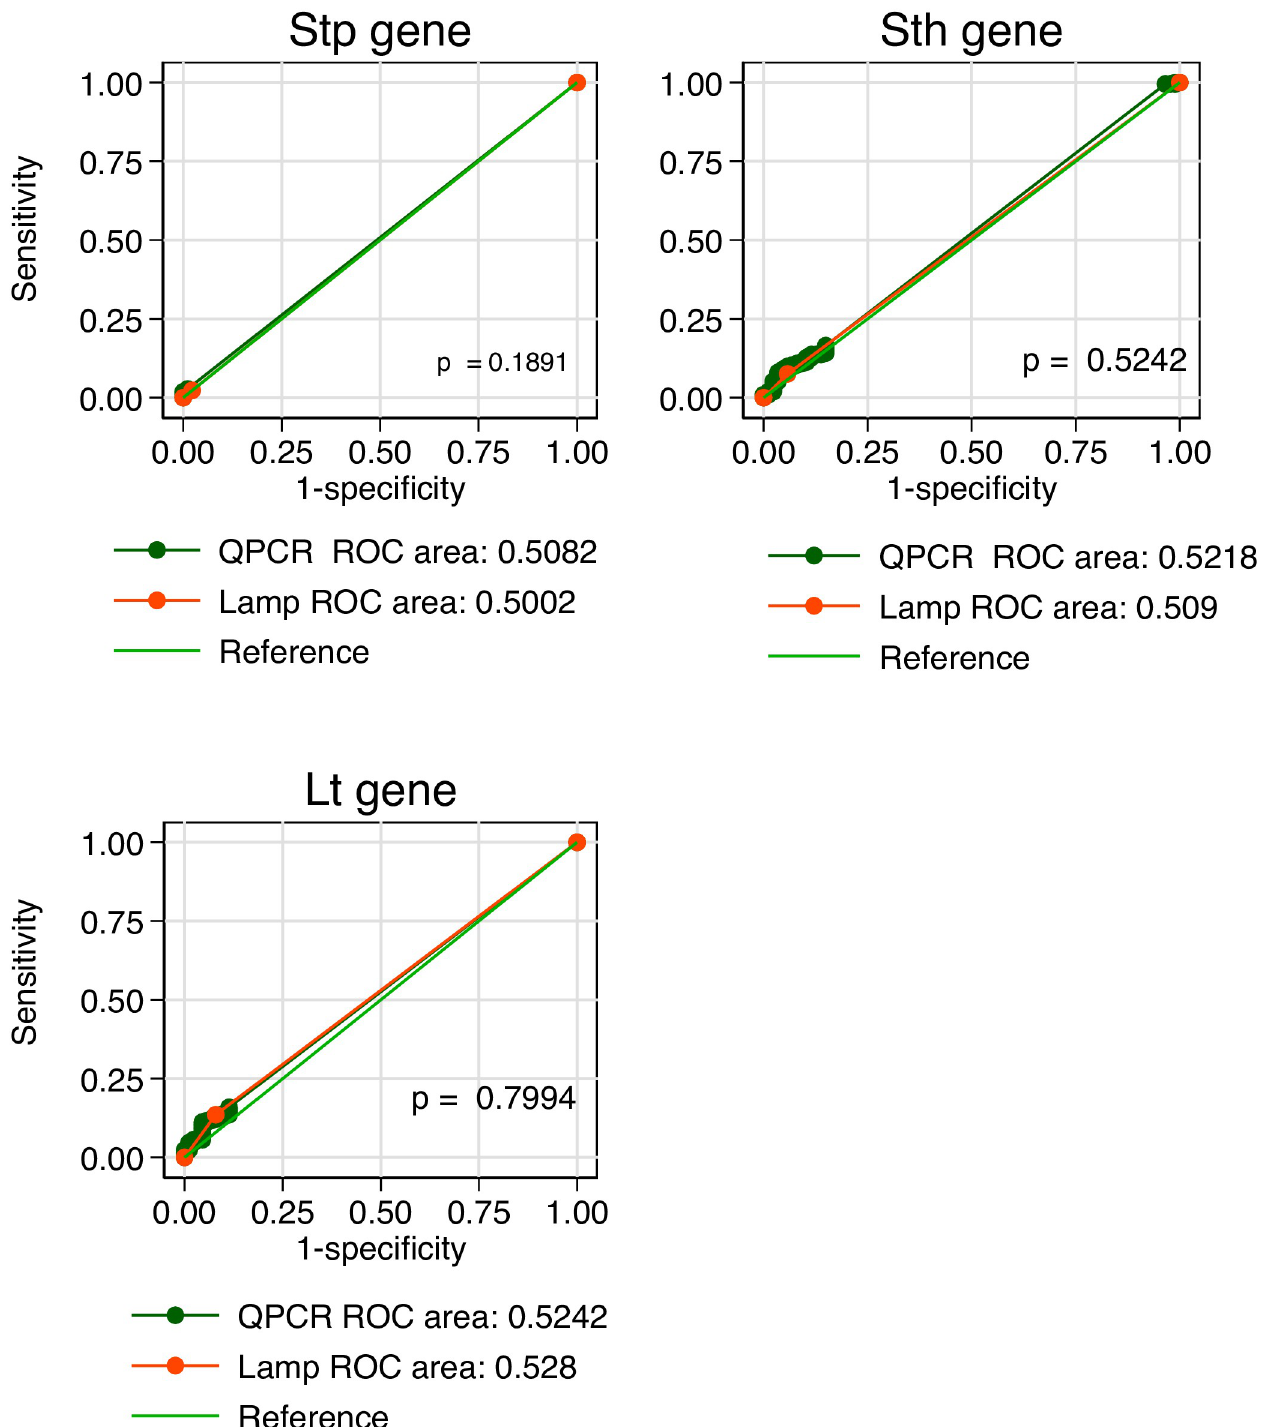
Fig 2. Comparison of RLDT to qPCR tests for each gene using AUC analysis. Note: � Statistical significance (p < 0.05).